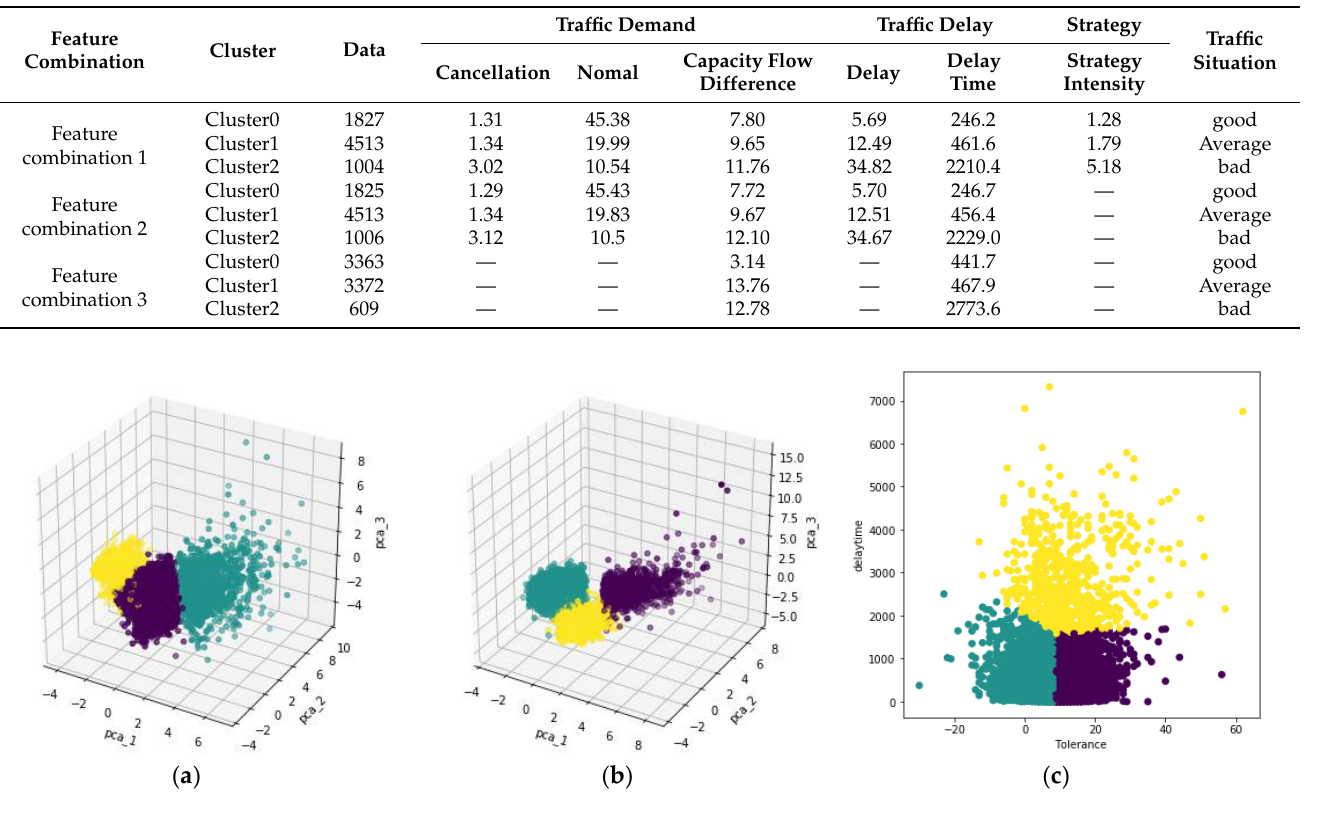
Figure 2. The classification results of Feature combination 1, Feature combination 2, and Feature combination 3 are visualized. ( a ) Feature combination 1; ( b ) Feature combination 2; ( c ) Feature combination 3.